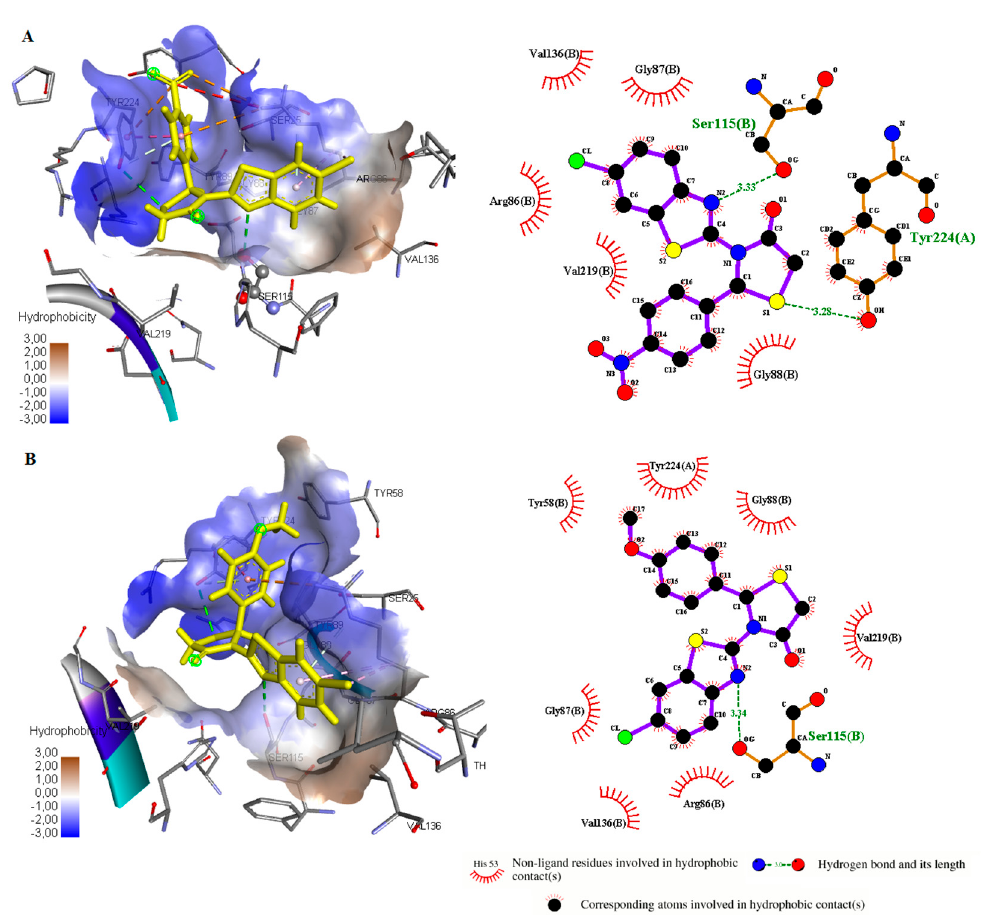
Figure 3. Docked conformations of the two most active compounds: A - 16 and B-18 in LdcA enzyme and 2D diagrams of ligand–enzyme interactions. Green dotted lines represent hydrogen bond.